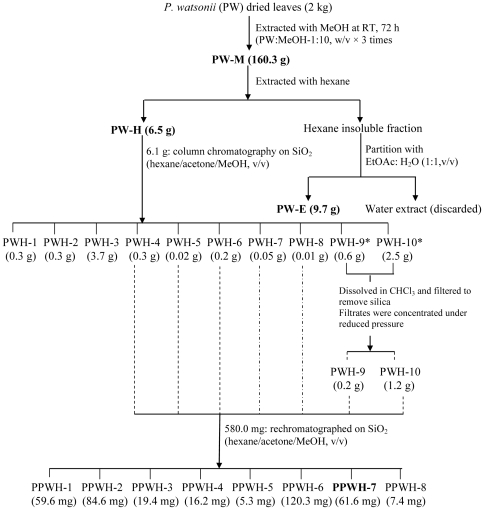
Flow chart of extraction procedure for P. watsonii.